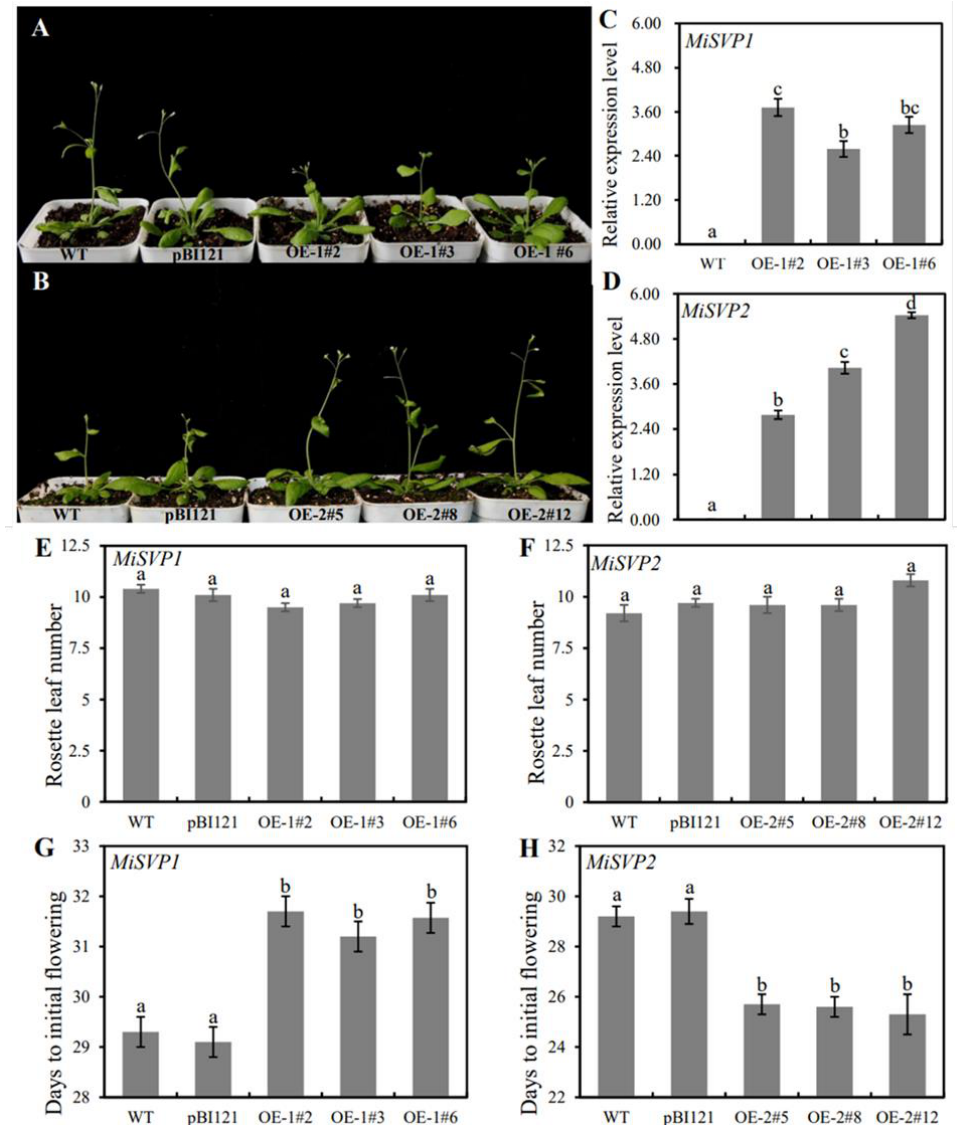
Figure 5. Effects of overexpression of MiSVP1 and MiSVP2 on the phenotype of Arabidopsis. ( A ) Phenotypes of MiSVP1 transgenic lines and controls. ( B ) Phenotypes of MiSVP2 transgenic lines and controls. The controls were WT and pBI121-GUS plants. ( C , D ) The expression levels of MiSVP1 and MiSVP2 in transgenic plants. ( E , F ) The number of rosette leaves of MiSVP1 and MiSVP2 transgenic lines and the WT. ( G , H ) The days to initial flowering of MiSVP1 and MiSVP2 transgenic lines and the WT. Duncan’s multiple range test was used to analyze the significance of differences among multiple groups of samples, and p < 0.05 indicated a significant difference. The error bars represent the standard error of the mean (± SE) among 12 replicates of the same sample.